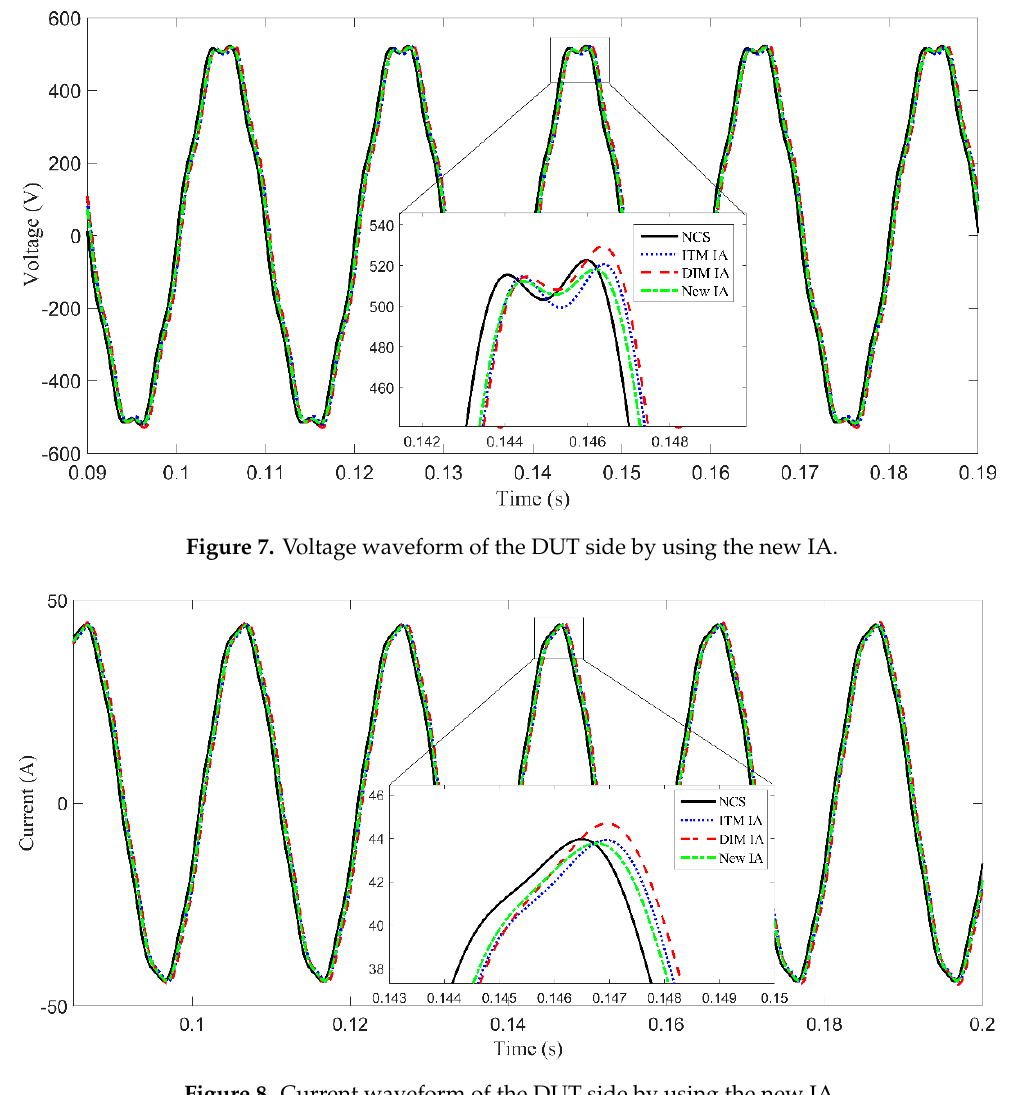
Figure 8. Current waveform of the DUT side by using the new IA.